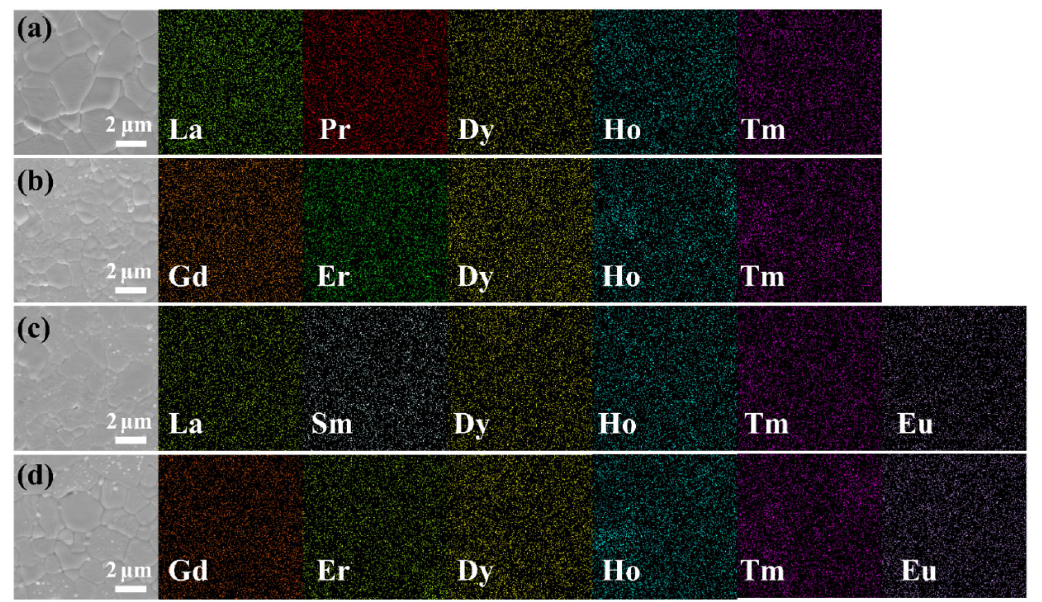
Fig. 2 Surface grains and RE elemental distributions of HEP RETa 3 O 9 ceramics: (a) (La 1/5 Pr 1/5 Dy 1/5 Ho 1/5 Tm 1/5 )Ta 3 O 9 (5HEP-1), (b) (Gd 1/5 Dy 1/5 Ho 1/5 Er 1/5 Tm 1/5 )Ta 3 O 9 (5HEP-2), (c) (La 1/6 Sm 1/6 Eu 1/6 Dy 1/6 Ho 1/6 Tm 1/6 )Ta 3 O 9 (6HEP-3), and (d) (Eu 1/6 Gd 1/6 Dy 1/6 Ho 1/6 Er 1/6 Tm 1/6 )Ta 3 O 9